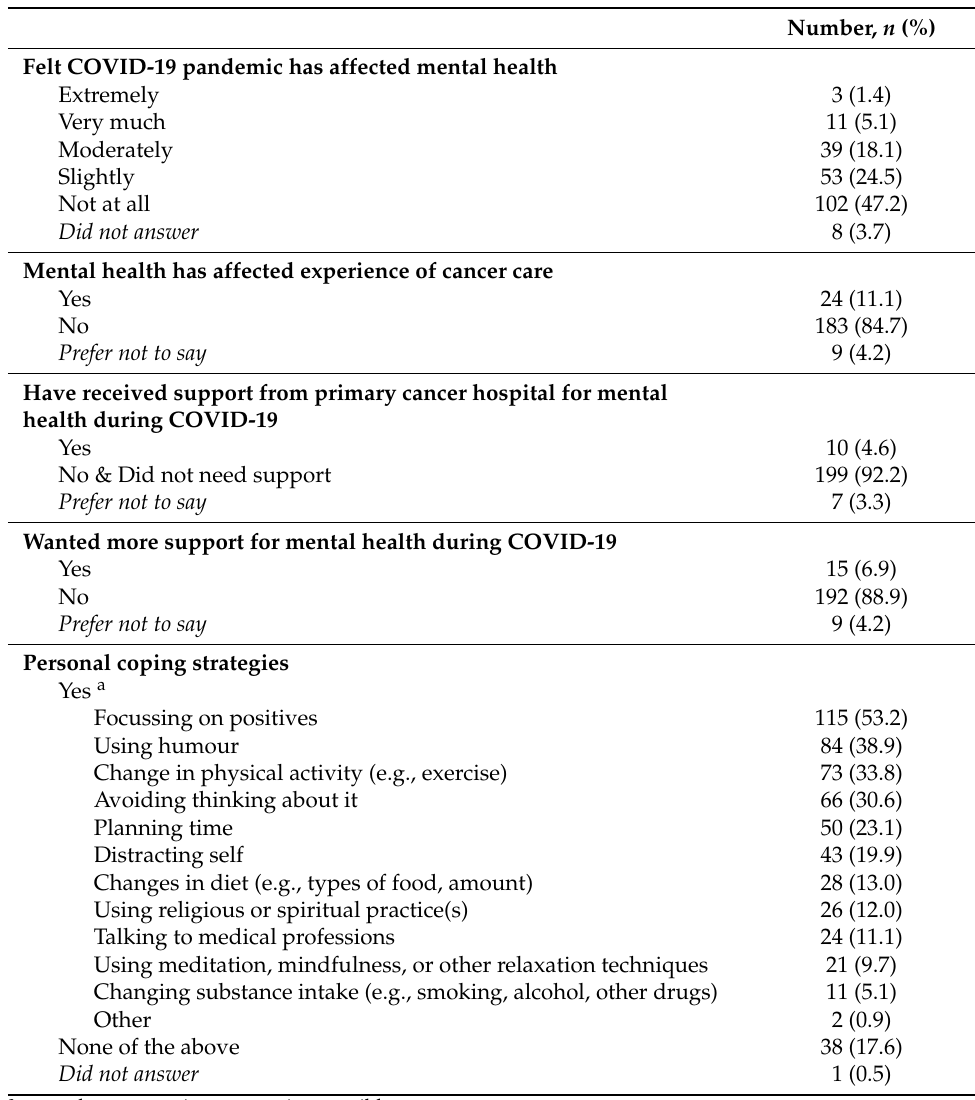
Table 2. The general impact of the COVID-19 pandemic on patients with colorectal cancer and support/coping strategies used ( n =